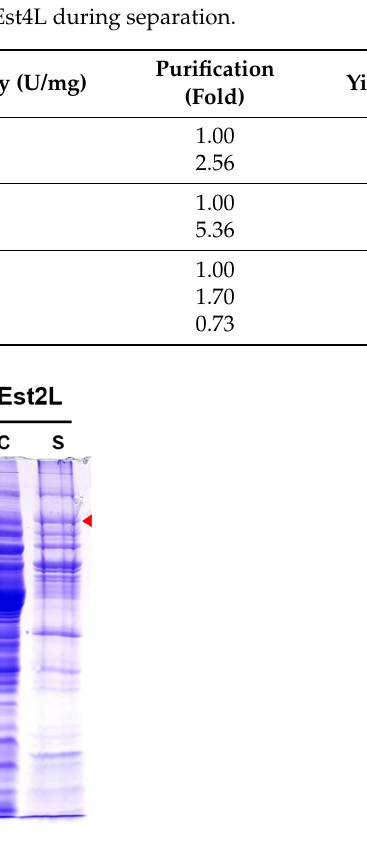
Figure 3. SDS-PAGE of Est2L and Est4L. M, size markers; C, crude extract; Q, HiTrap-Q pool; S, Sephacryl S-200 HR pool. Arrows represent the predicted protein bands corresponding to the molecular masses of Est2L and Est4L.